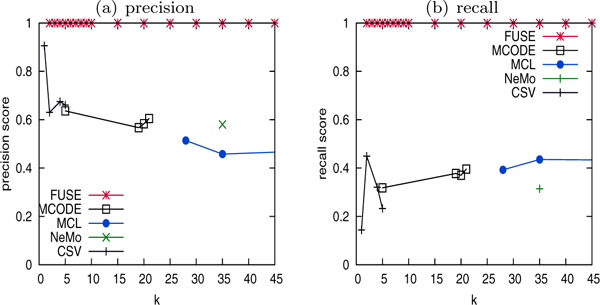
Function representativeness.